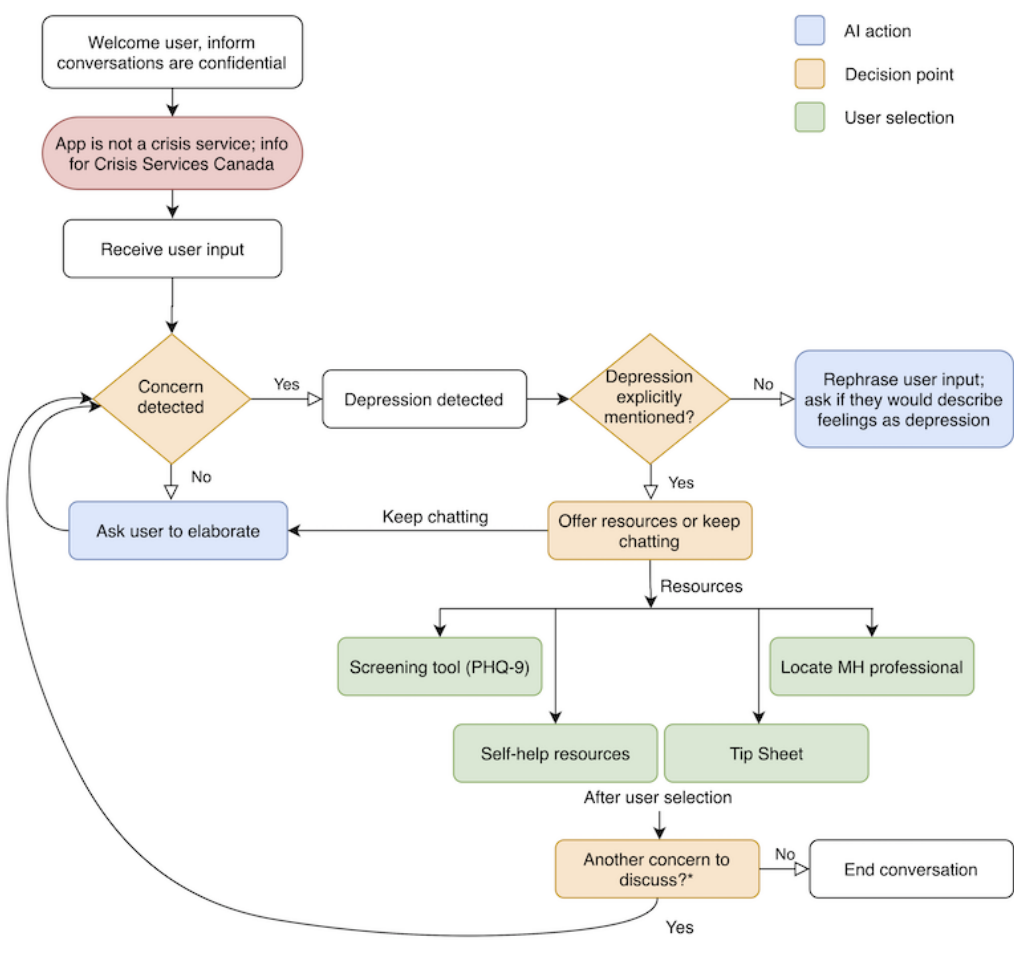
Figure 1. Demonstration of the basic functionality of the Here4U app, using depression as an example of a pressing concern. If the user has indicated an additional concern, the subsequent conversational flow (and end point options or resources provided) would change to reflect the new concern. *An additional concern may be expressed by the user at this point (AI prompt: “Is there anything else you wanted to chat about today?”) or from appended additional concerns (eg, if more than one concern is detected at the beginning of the conversation). AI: artificial intelligence; MH: mental health; PHQ-9: Patient Health